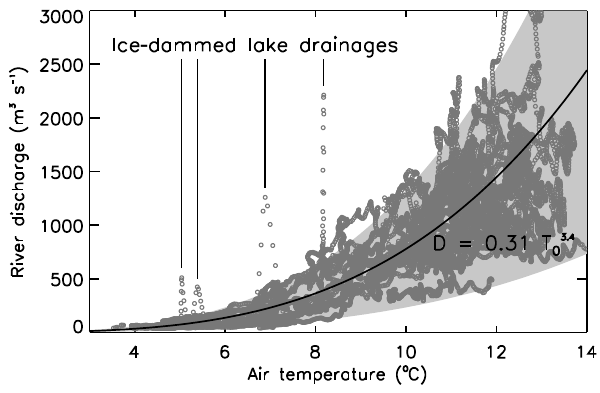
Figure 4. Hourly values of river discharge versus 10-day smoothed air temperature in Kangerlussuaq for July–September data 2008– 2015 (dark grey). The solid line denotes a power-function fit to the data, with the light grey area the 70% uncertainty range. Ice- dammed lake drainages ( jökullaups ) stand out as